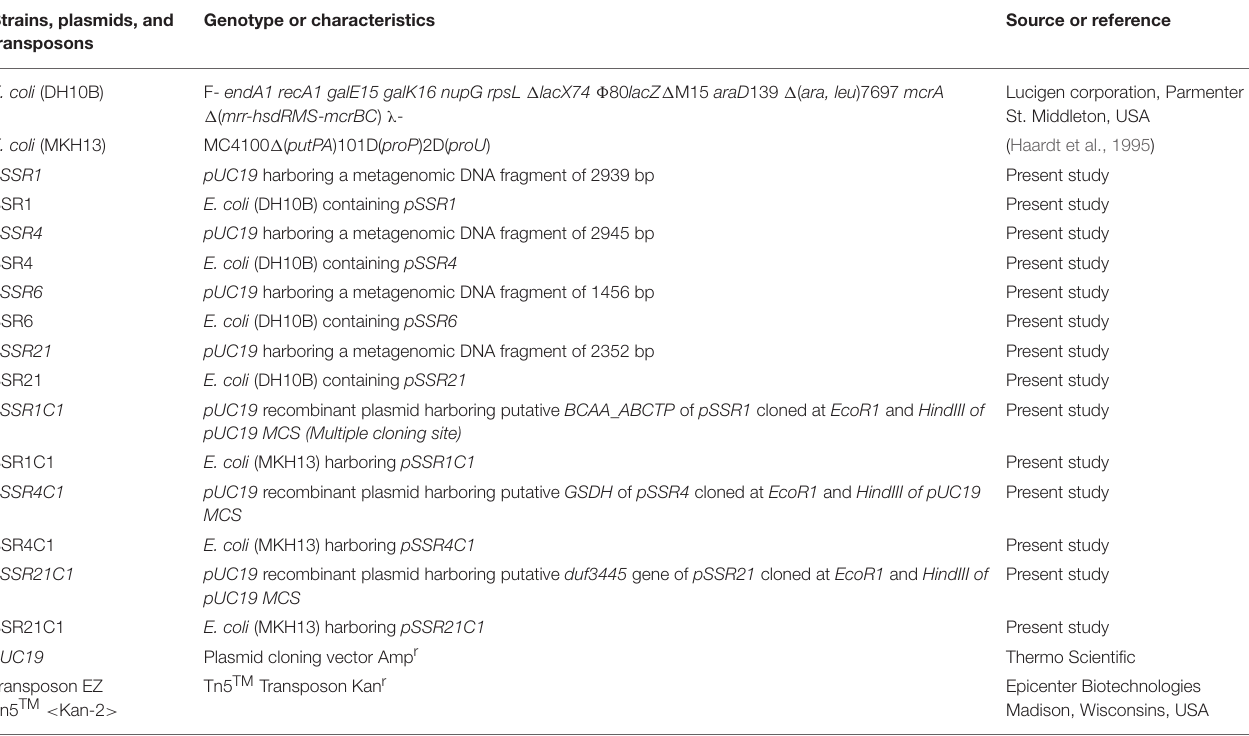
TABLE 1 | Bacterial strains and plasmids used in present study. Strains, plasmids, and